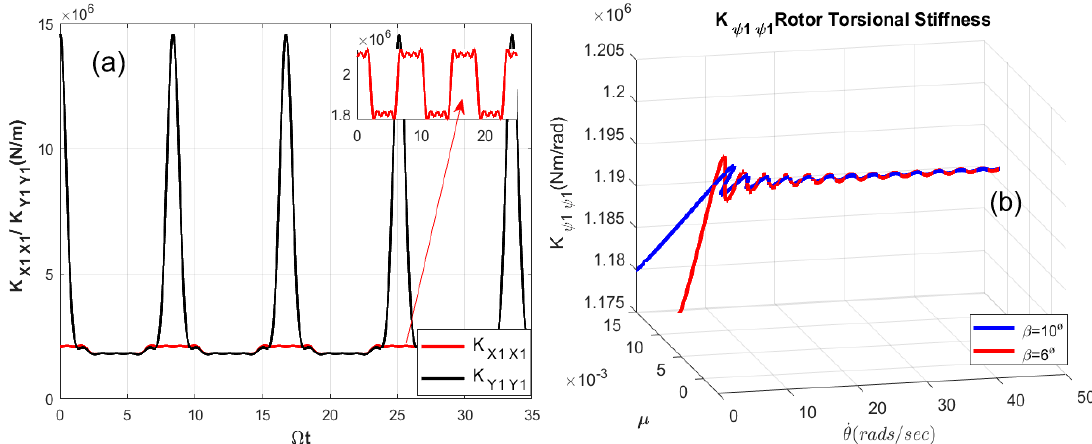
Figure 3. ( a ) Breathing shaft stiffness for ε 1 c = 0.3, ( b ) Torsional stiffness variation with speed for two joint